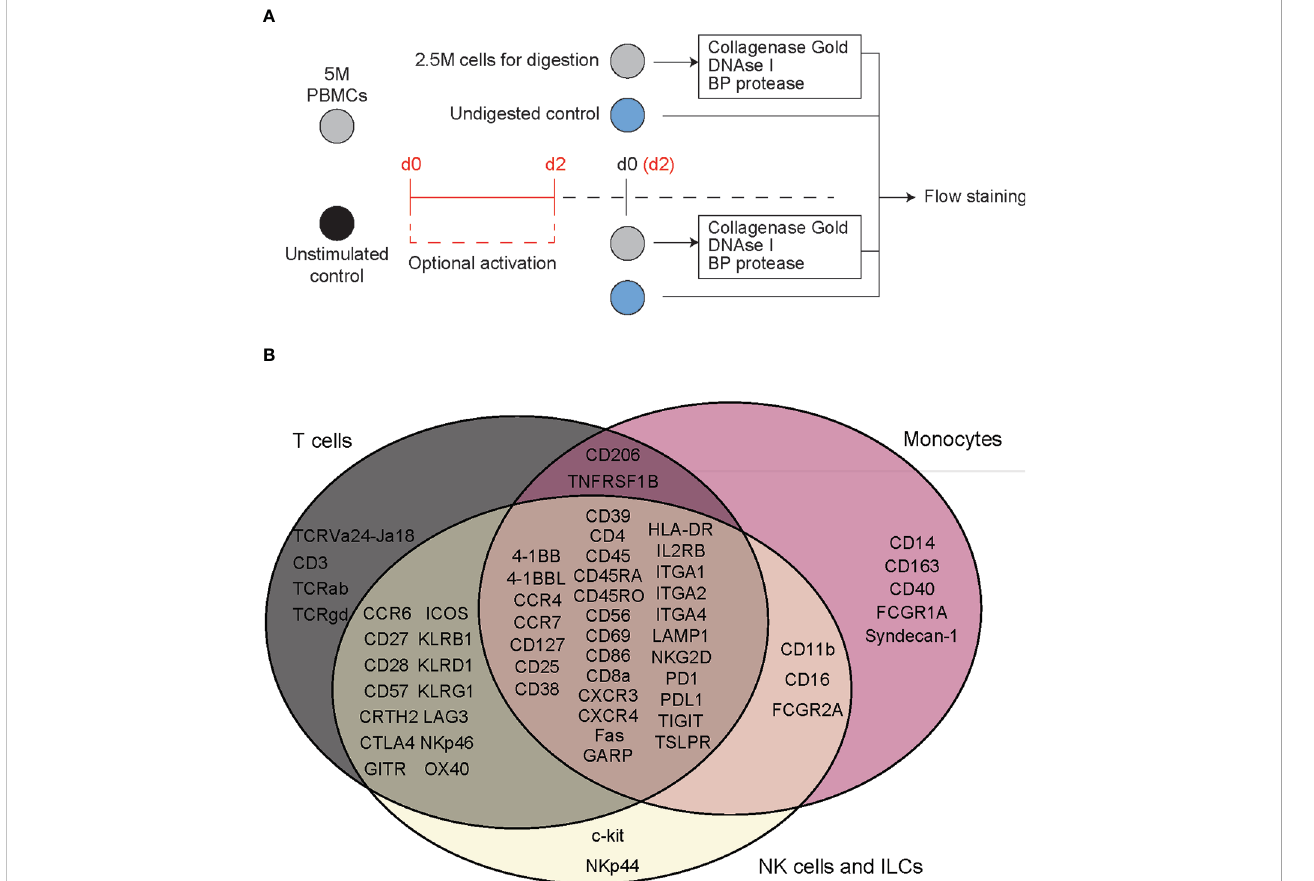
FIGURE 1 Flow cytometry reveals T cell speci fi c, deleterious effects of islet digestive enzymes on staining of antibody clones used for generation of TotalSeq-C oligo-antibodies. (A) Activated or non-activated PBMCs were treated with a digestive enzyme solution and stained with fl ow cytometry antibodies corresponding to clones used in the TotalSeq-C commercial antibody catalogue of oligo-antibodies used for CITE-seq. (B) Markers were selected to identify key cellular subsets of T lymphocytes, monocytes, and innate lymphoid cells, in addition to other antibodies used for e.g., leukocyte selection, stress indicators, and immune